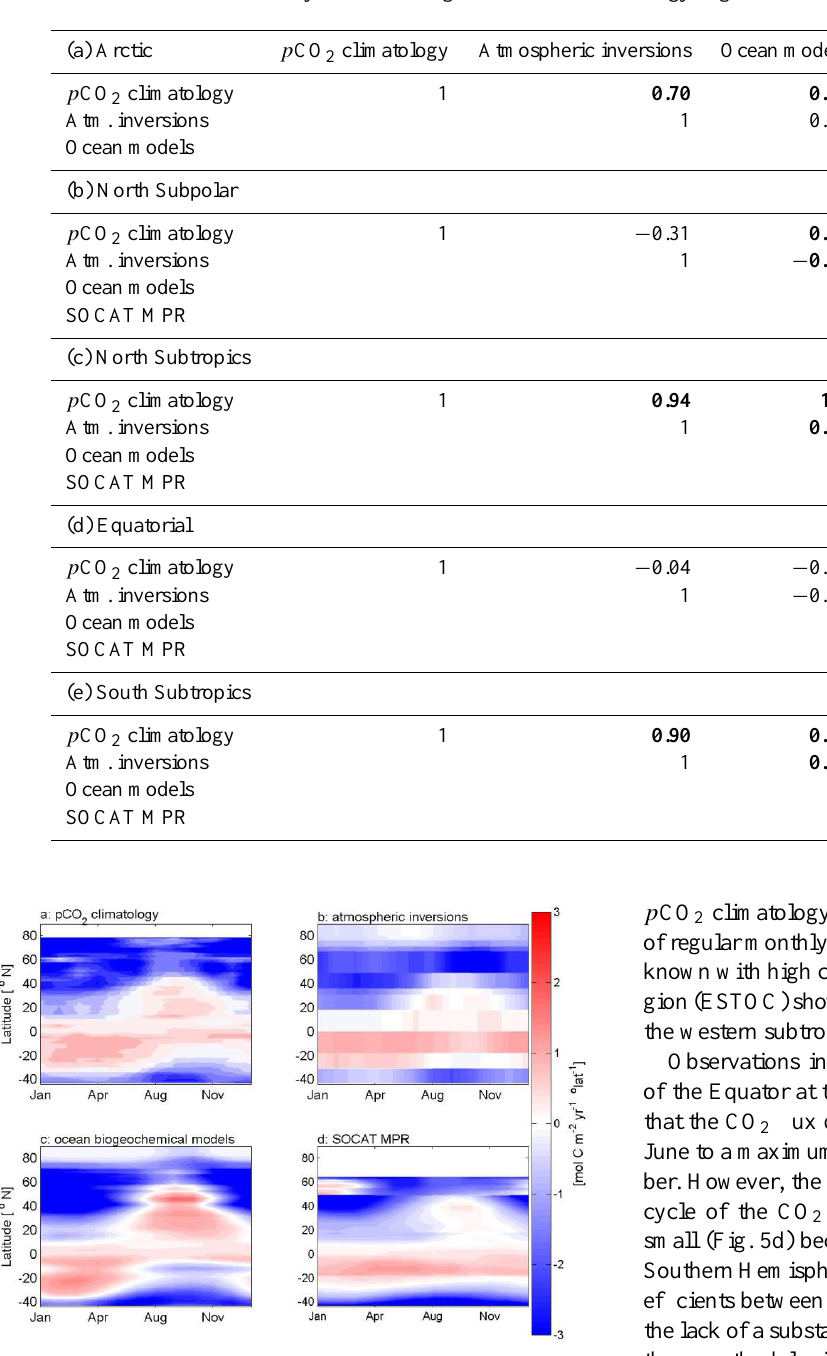
Table 5. Correlations of seasonal cycle for each region and each methodology. Significant correlations ( p < 0.05) are in bold.